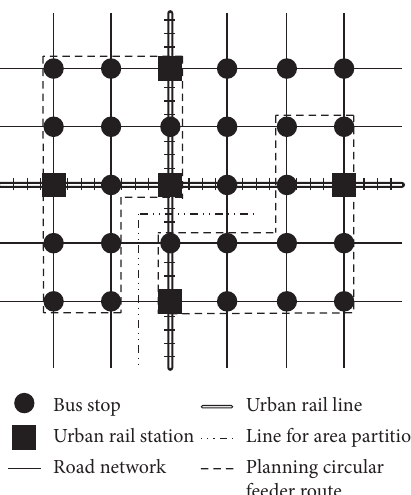
Figure 1: An example service network and planned feeder bus